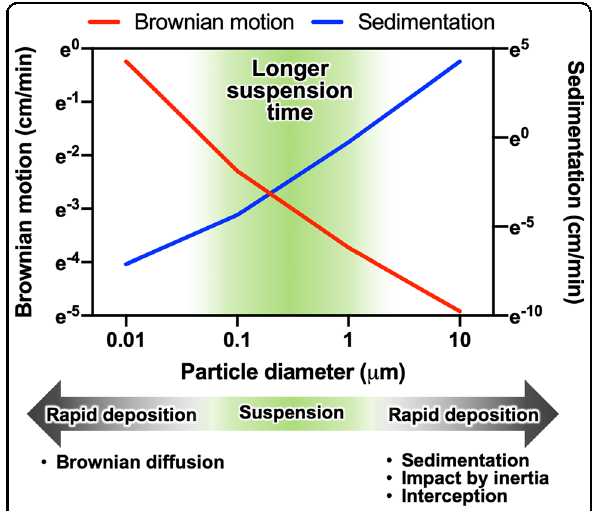
Fig. 3 Deposition of particles according to size distribution. Ultra fi ne particles are rapidly deposited by Brownian diffusion, especially particles <20 nm. Large coarse particles are deposited by sedimentation, impact by inertia, and interception. Particles between 30 nm and 1 μ m tend to have longer atmospheric lifetimes because they are less likely to be deposited in either way. These particles accumulate in the atmosphere due to the long suspension time and are thus called the accumulation mode.